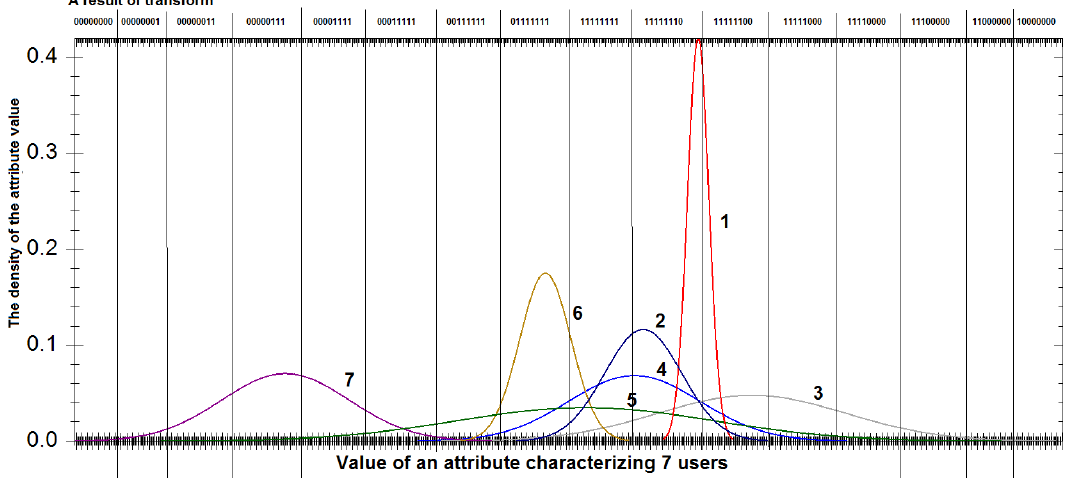
Figure 4. Encryption of values of resulting bit sequences.